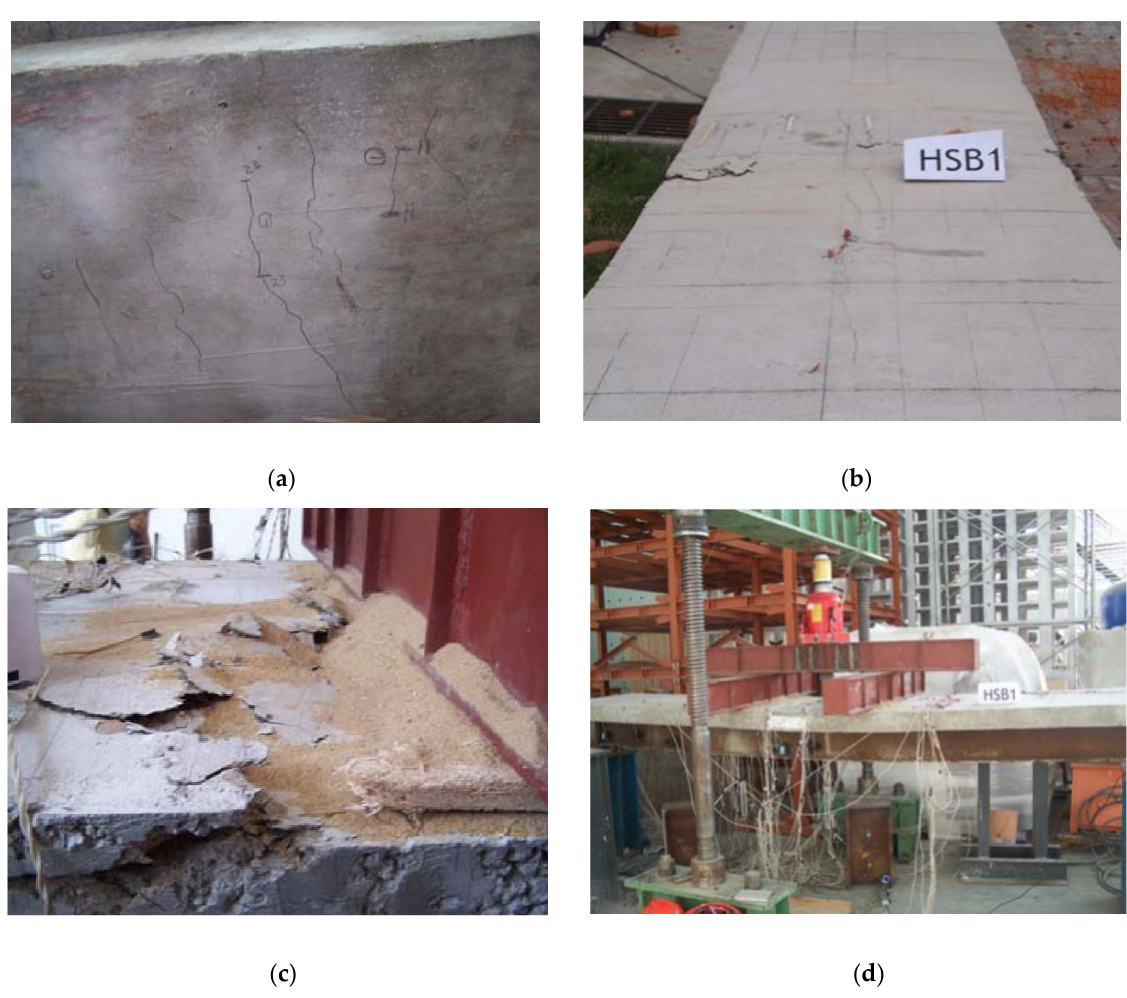
Figure 4. Failure mechanisms of composite beam HSB1: ( a ) transverse cracks at concrete slab bottom, ( b ) longitudinal cracks at concrete slab surface, ( c ) compression fracture of concrete flange, and ( d ) flexural failure of steel member.